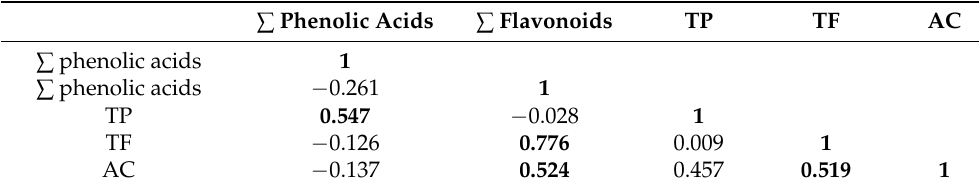
Table 3. Correlation matrix between apples’ phenolic compounds profile and bioactive properties. ∑ Phenolic Acids ∑ Flavonoids TP TF AC ∑ phenolic acids 1 ∑ phenolic acids − 0.261 1 TP 0.547 TF − 0.126 −